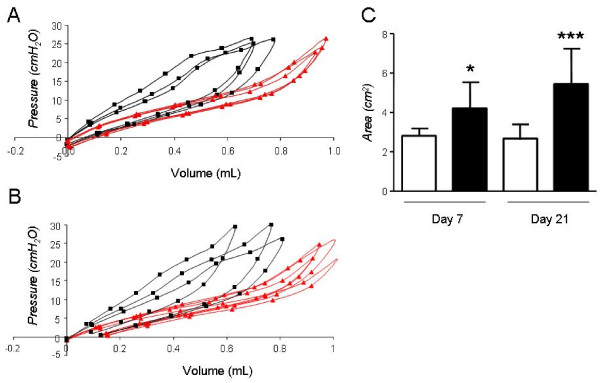
Pressure-Volume curves in C57BL/6 mice. Sample Pressure-Volume curves obtained 7 days (A) and 21 days (B) after intratracheal bleomycin (black squares) or saline (grey triangles) to C57BL/6 mice. Cumulative results of PV-curve area for early and late time-points.(C). *P < 0.05, **P < 0.01, and ***P < 0.001 compared with saline-treated controls. Columns, mean; bars, SD.